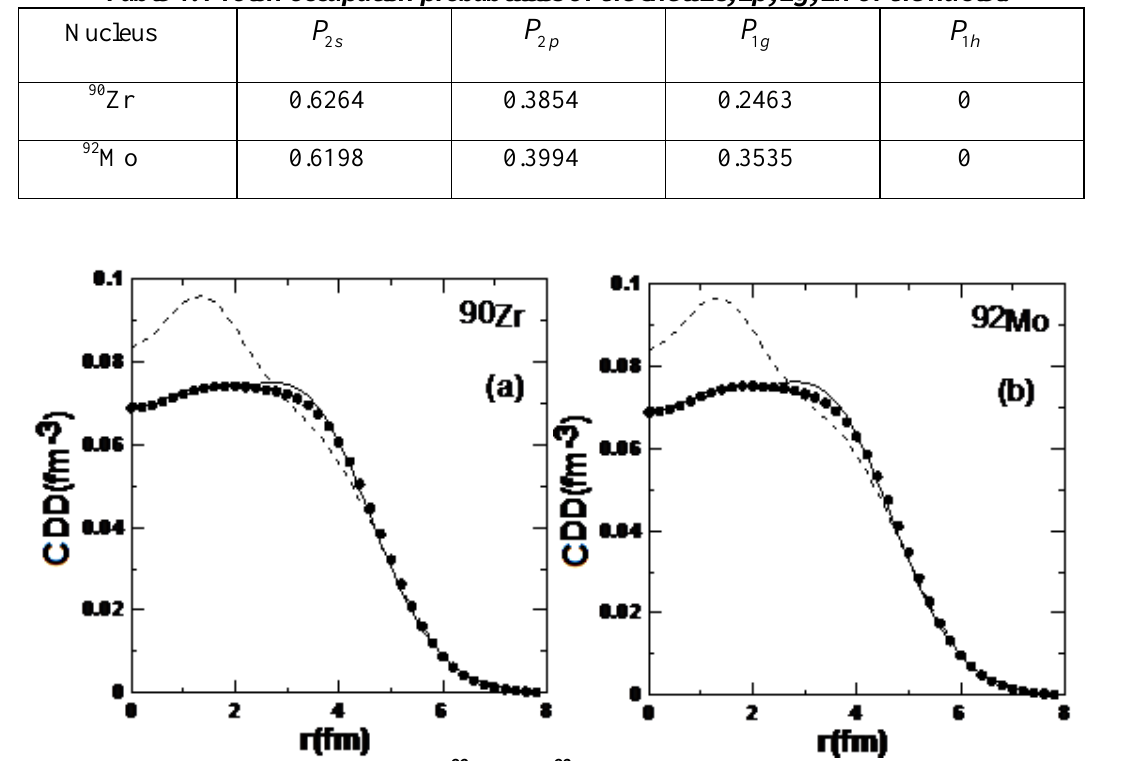
Fig.1: Dependence of CDD on r for 90 Zr and 92 Mo nuclei. The dashed and solid curves are the calculated CDD of equation (2) when 0, dotted symbols are the best fitted to the experimental data for FB [17,